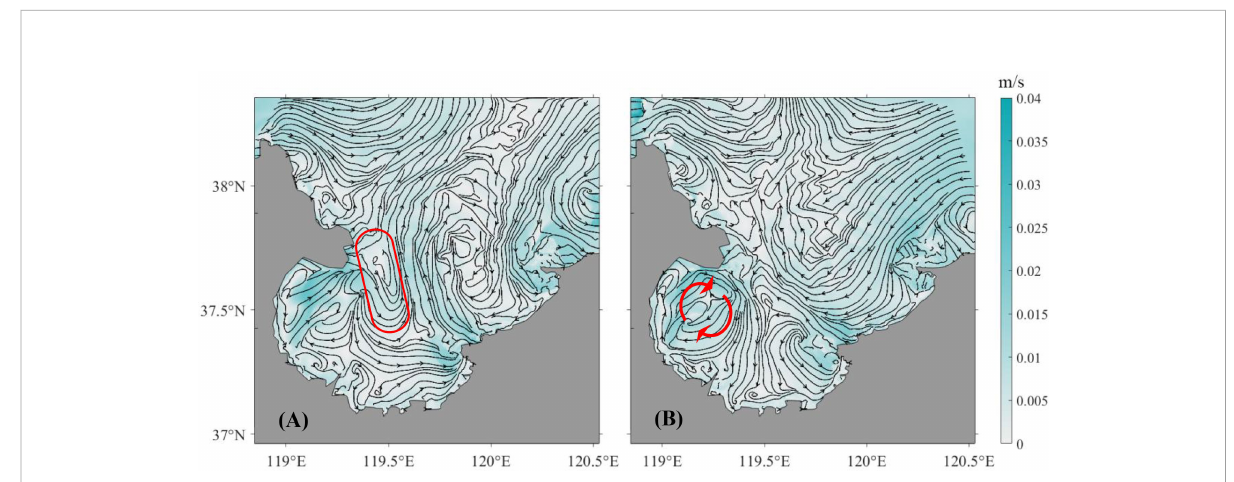
FIGURE 6 Lagrangian residual current velocity with respect to time t = 300 h at low tide (A) and high tide (B) in the